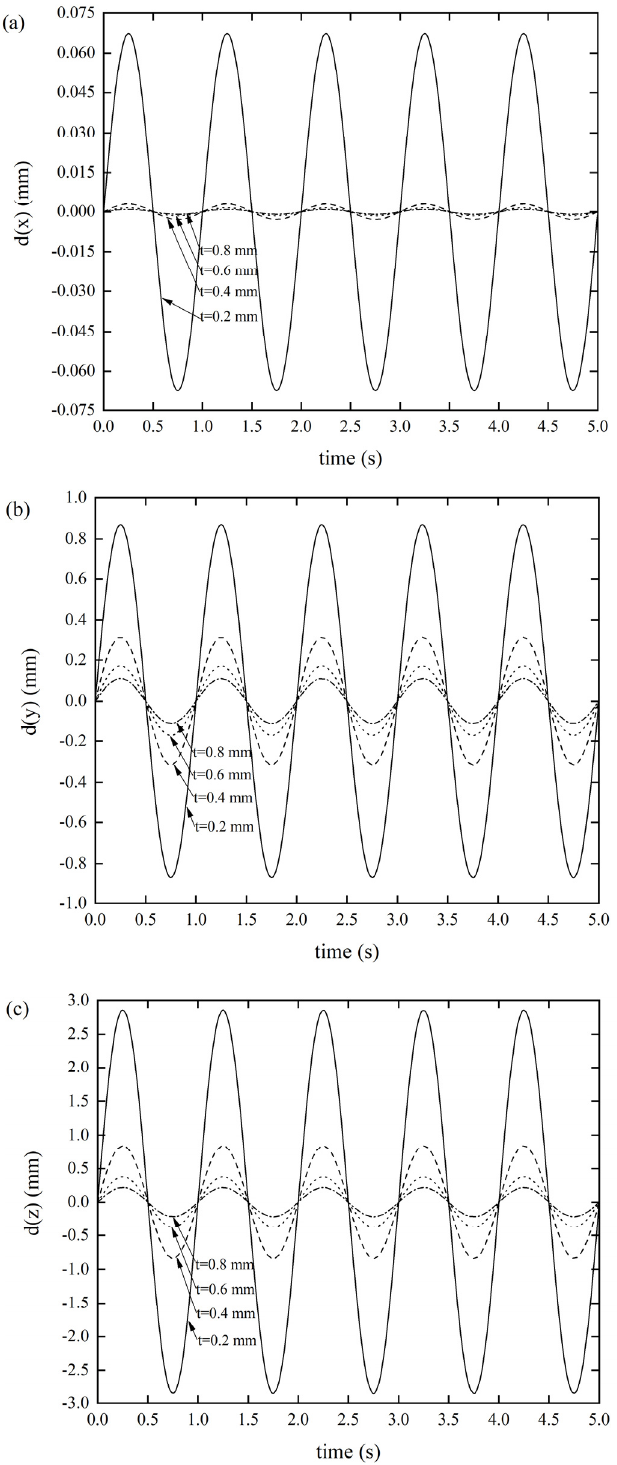
Figure 5. DDR of the Miura tube with different thicknesses t ( θ = 130 ° , a/b = 1) ( a ) x -displacement of the Miura tube under force along the x -direction, ( b ) y -displacement of the Miura tube under force along the y -direction, and ( c ) z -displacement of the Miura tube under force along the z -direction.